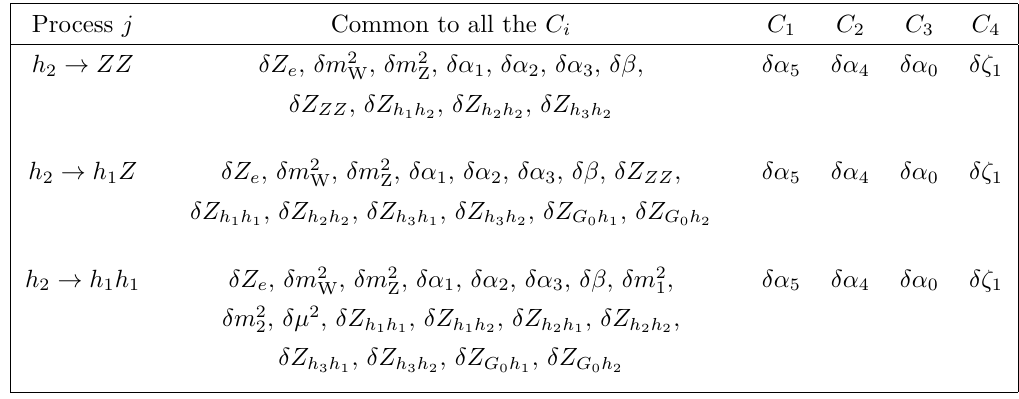
for the combinations C i . j